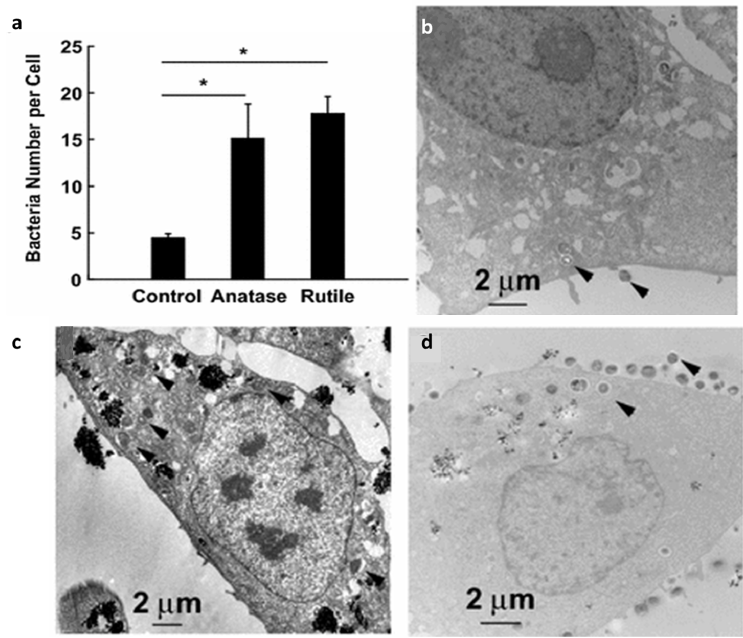
Figure 5. The effect of TiO 2 NPs on infectious bacteria S. aureus in HeLa cells. The number of bacteria S. aureus in control vs. anatase and rutile exposed HeLa cells ( a ). TEM cross-sections of HeLa control cells ( b ), cells exposed to 0.1 mg/mL anatase ( c ), and 0.1 mg/mL rutile TiO2 ( d ) followed by exposure to S. aureus bacteria for 90 min. Arrows point towards bacteria. * Means p < 0.05. This figure was